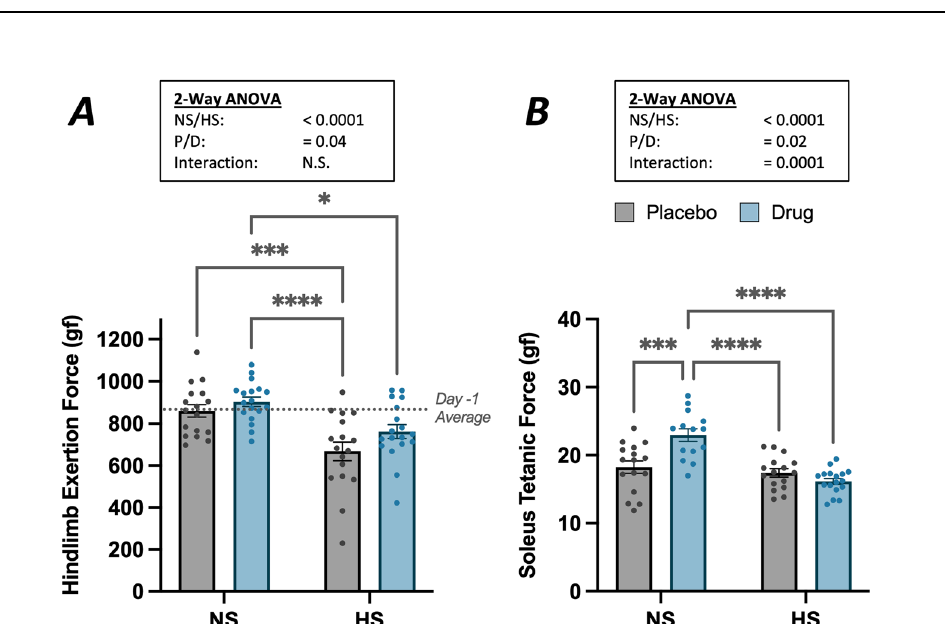
Fig. 2 In vivo and in vitro muscle force assessment. A Hindlimb exertion force test (HEFT) results obtained on Day 13 of the study show signi fi cant effects of both suspension ( p < 0.001) and treatment ( p = 0.04) with two-way ANOVA. Tukey ’ s tests reveal signi fi cant differences with unloading but increases in force generation with anti-myostatin peptibody treatment did not reach signi fi cance, as indicated by dissimilar letters. Data are presented as mean ± SEM, n = 17 – 18 mice/group; α = 0.05. B Tetanic force measurement was performed in vitro from the soleus muscle. Two-way ANOVA revealed signi fi cant effects of suspension ( p < 0.001) and treatment ( p = 0.02) along with a signi fi cant interaction effect ( p < 0.001). Posthoc Tukey ’ s revealed a signi fi cant difference with anti-myostatin peptibody treatment in non- suspended (but not in suspended) mice, as indicated by dissimilar letters. Data are reported as the mean ± SEM for each group, n = 15 – 17 mice/group; α = 0.05.